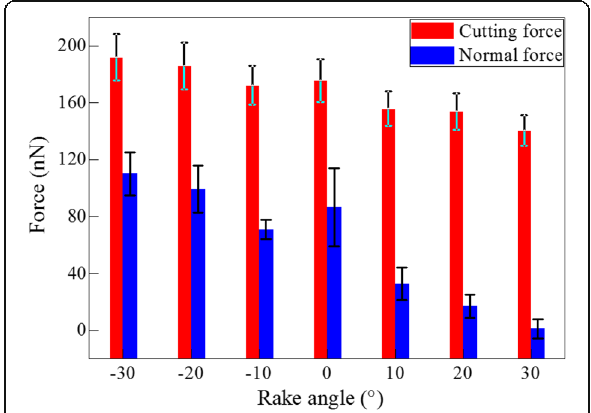
Fig. 6 Rake angle dependence of machining force; (color online) influence of rake angle on machining force